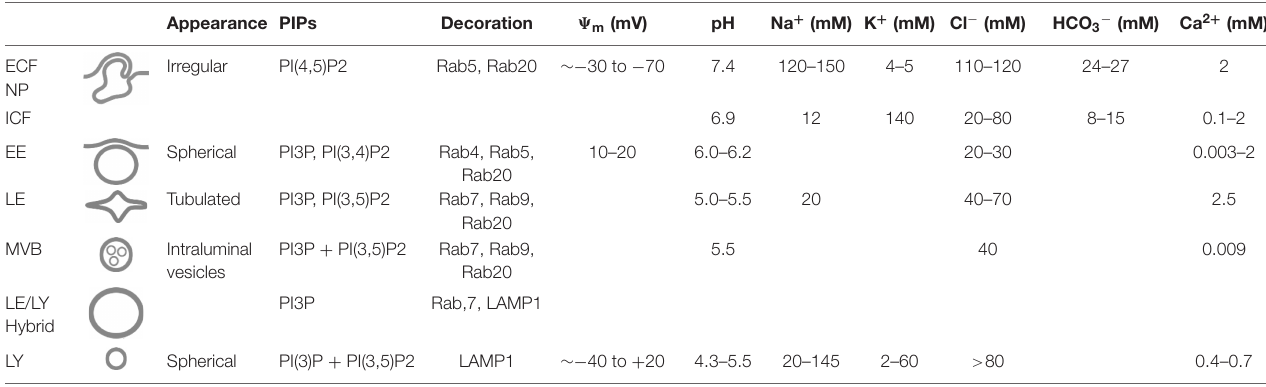
TABLE 1 | Some characteristics and ion concentrations of macropinocytosis and the endolysosomal pathway.